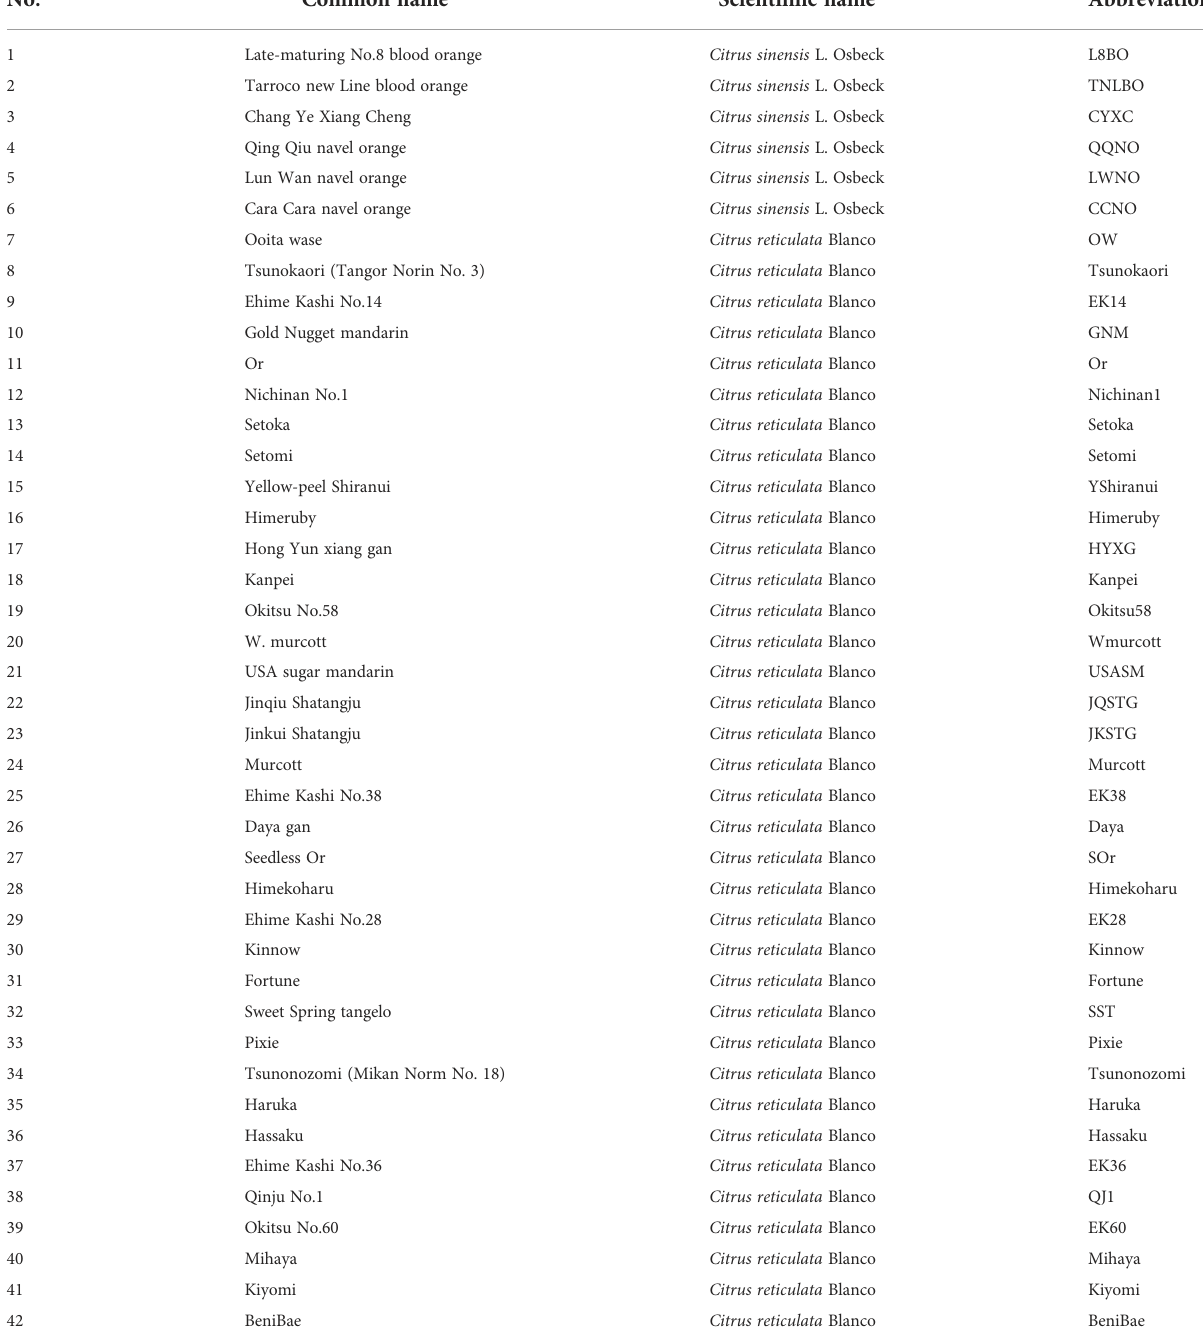
TABLE 1 Citrus cultivars used in this